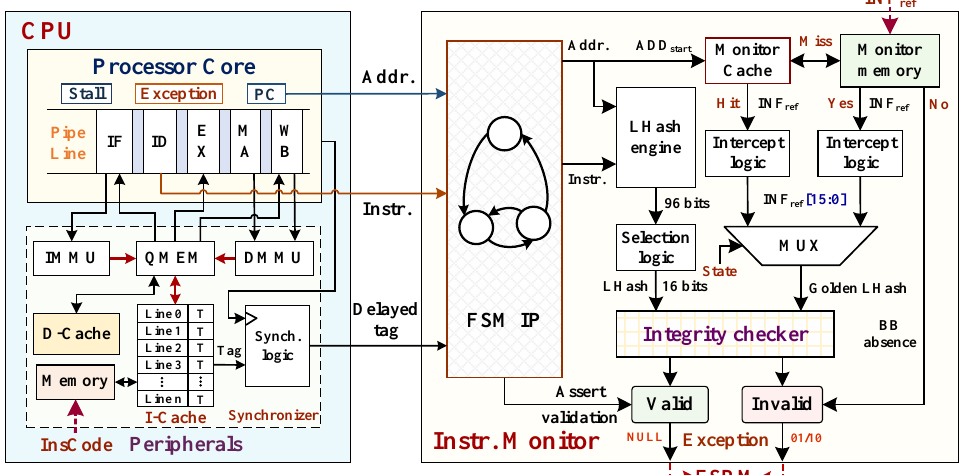
Figure 6. The hardware implementation details of the instruction monitor connecting with the